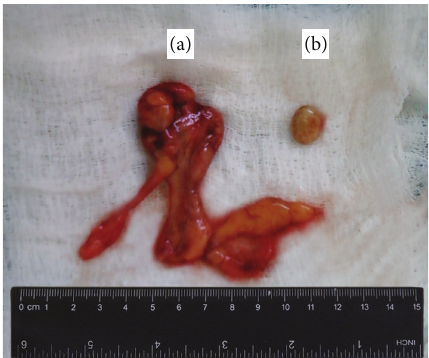
Figure 2: The removed specimen: an epiploic appendage (a) and a free fatty body (b) found in the hernia